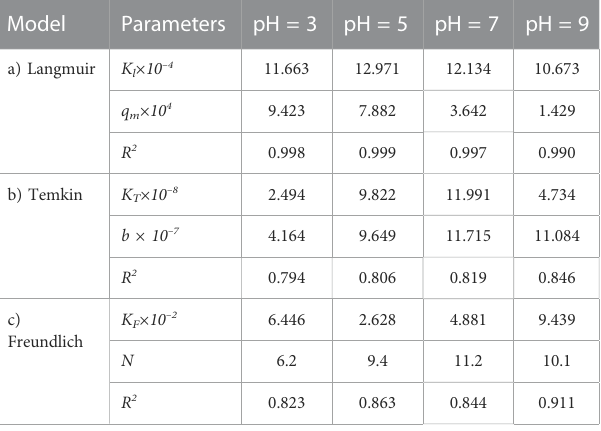
TABLE 11 Parameters of a) Langmuir, b) Temkin, and c) Freundlich isotherm models at different pH values using Oil sludge 4 as carbon active at T = 318 K and adsorbent concentration of 100 mg/L.